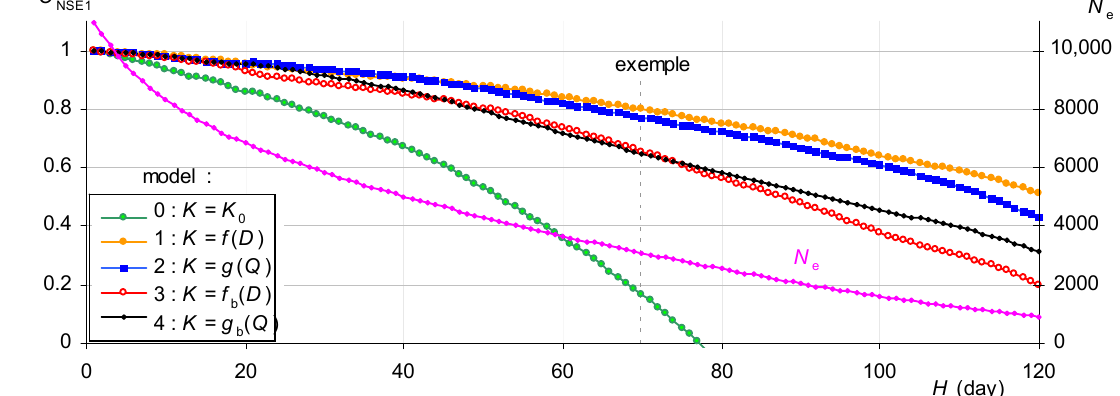
Figure 11. Performance of models in forecasting discharge during recession periods at Daka Saidou on the Bafing, according to the forecast horizon.